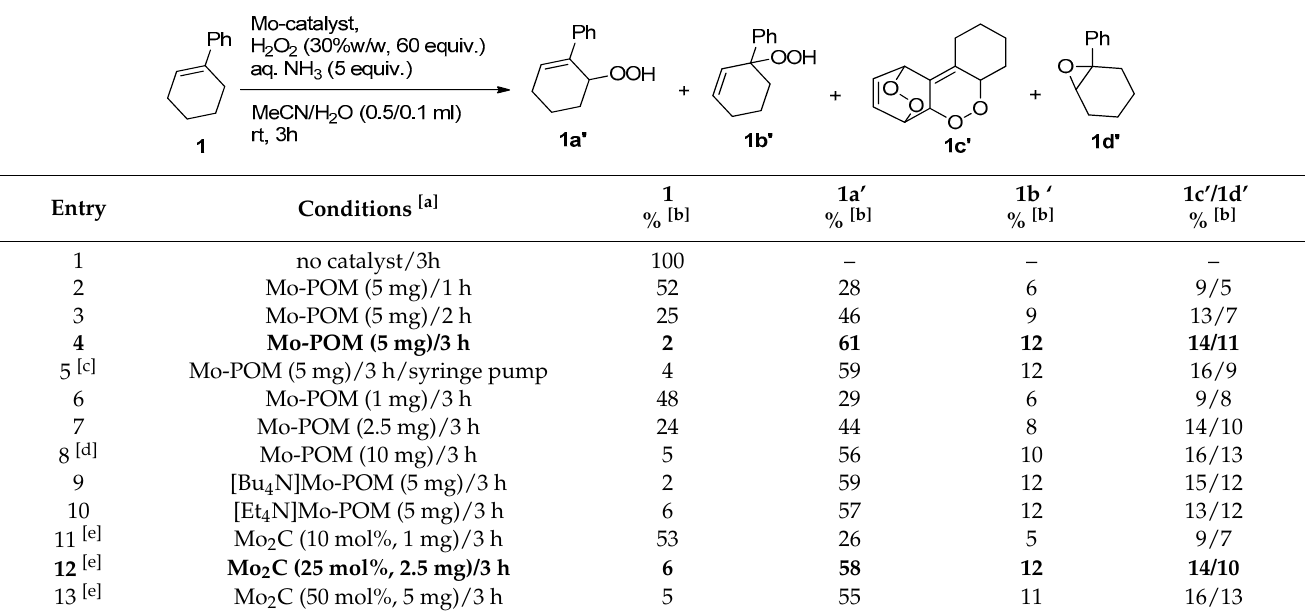
Table 1. Evaluation of conditions in the Mo-catalyzed oxygenation of 1 .